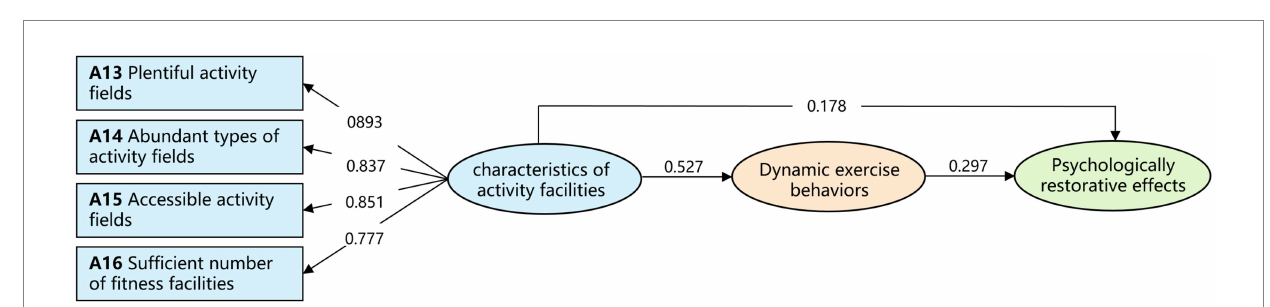
FIGURE 10 Influence effect illustration of the characteristics of activity